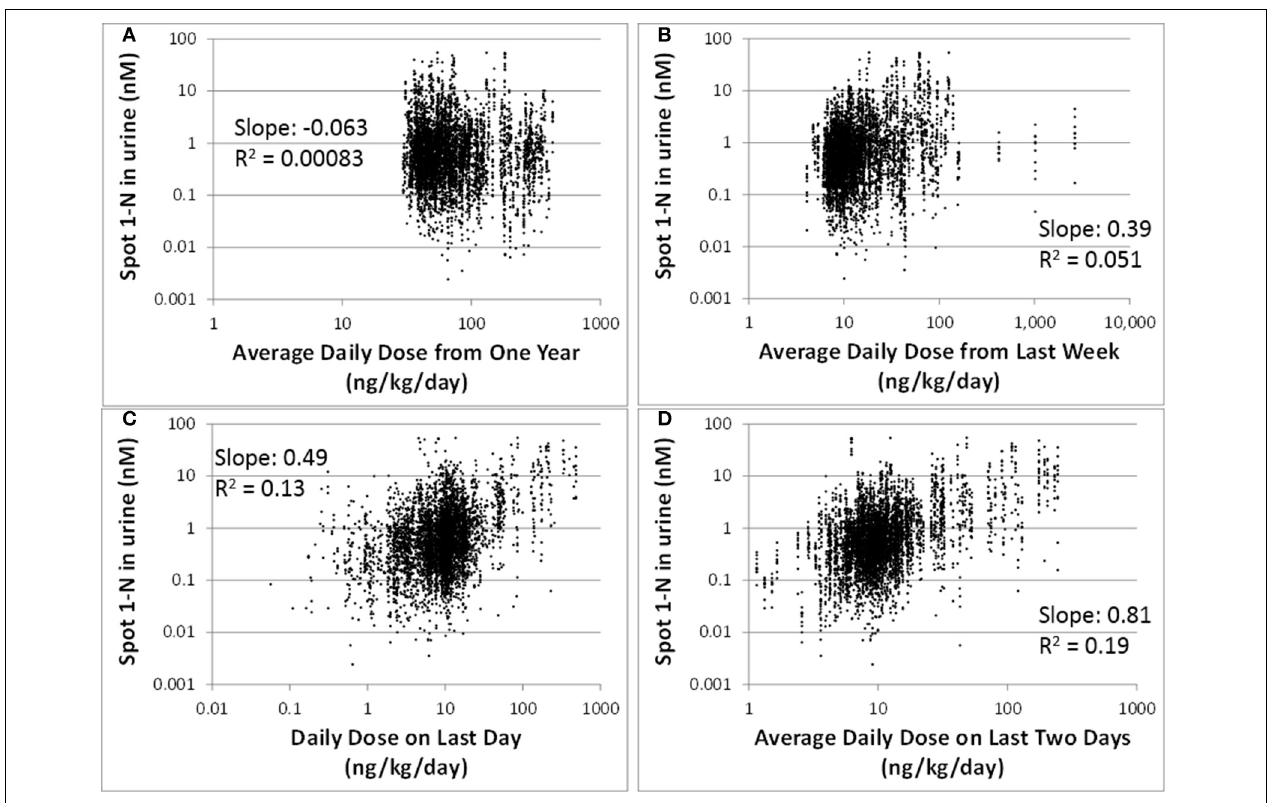
FIGURE 2 | Spot 1-N concentrations in urine (nM) vs. average daily doses from four exposure periods (ng/kg/day) for 5000 simulations. (A) Exposure doses averaged over the past year.